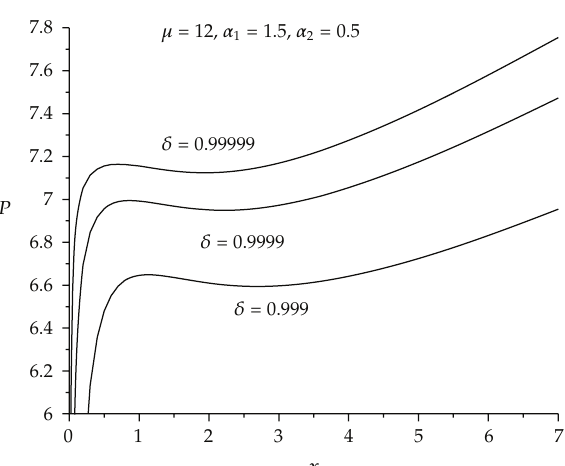
Figure 4: Curves of P ∼ x for di ff erent values of δ